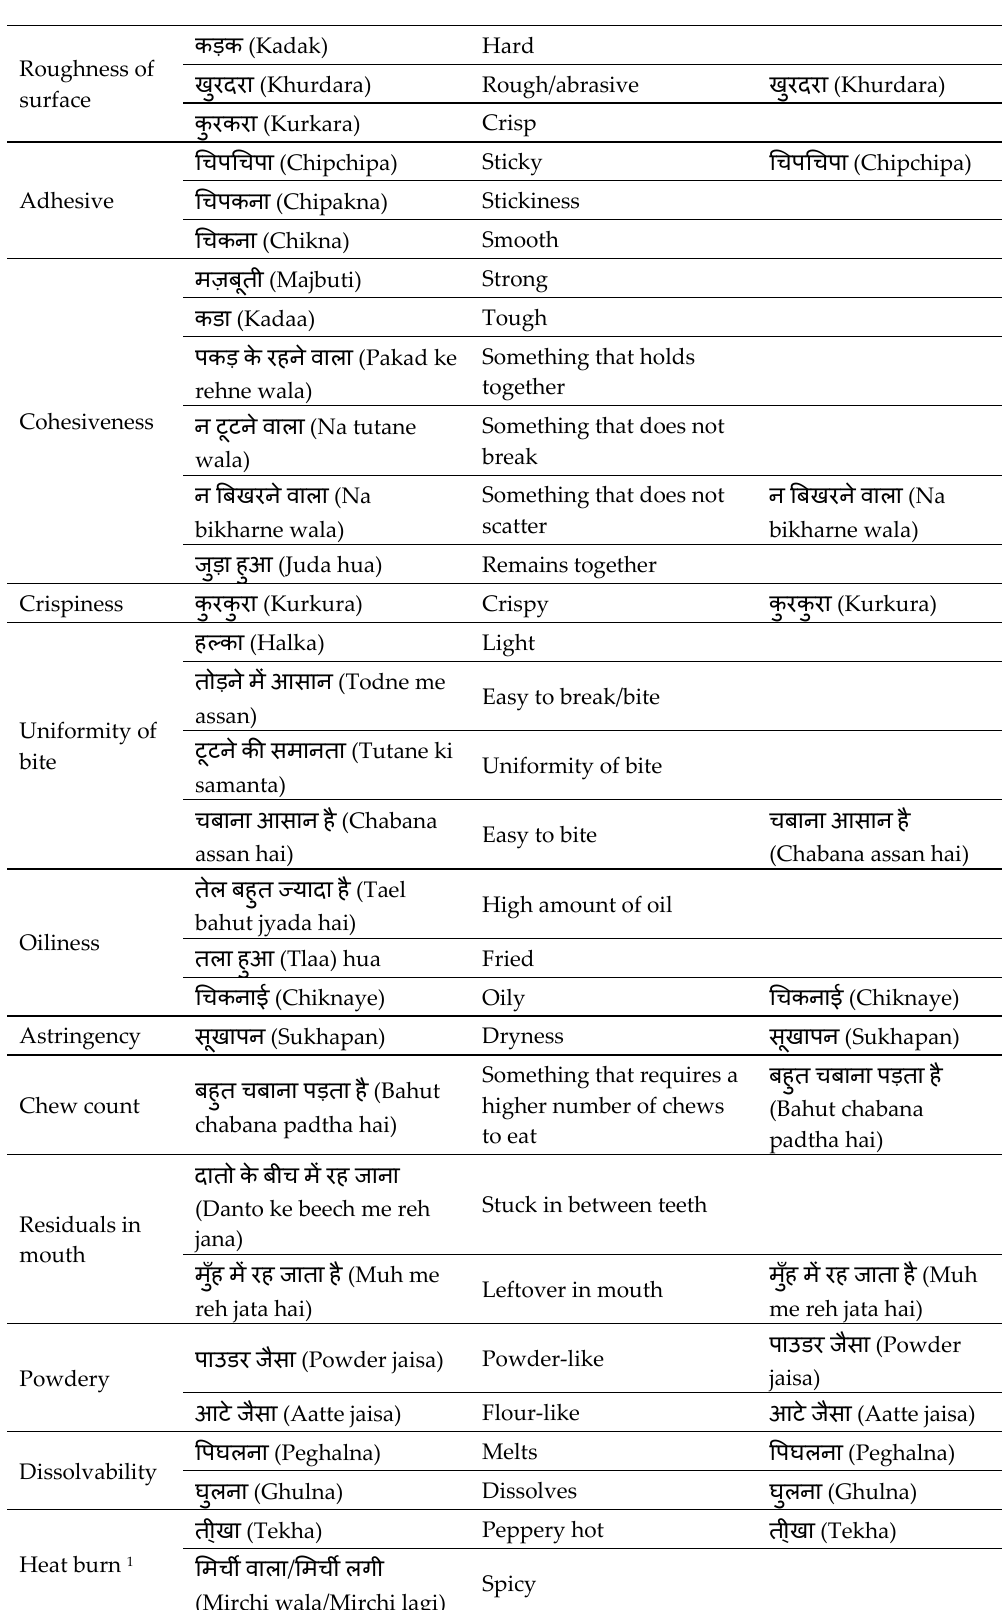
Table 5. Cont. Foods 2019 , 8 , x FOR PEER REVIEW 11 of